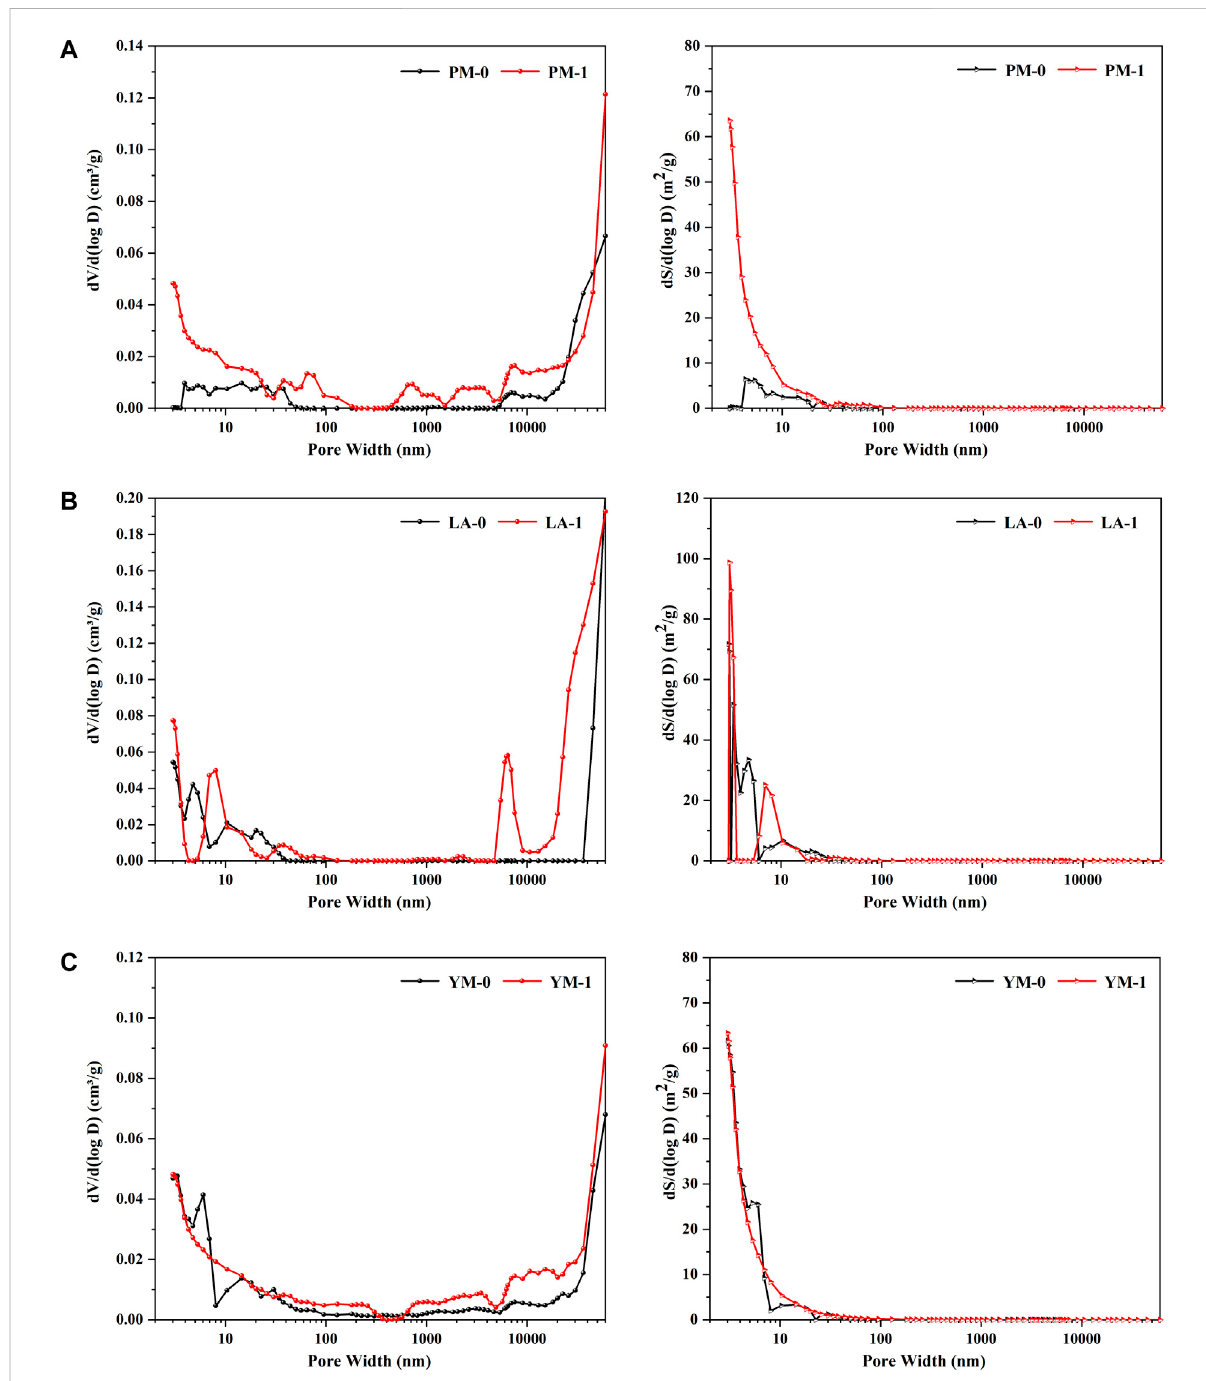
FIGURE 6 Pore volume distribution curves and pore area distribution curves from the MIP measurement: (A) PM; (B) LA; (C) YM.